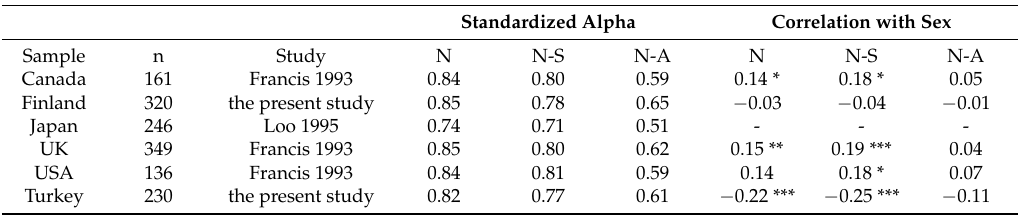
Table 1. Reliability coefficients and correlations with sex for the sex-related (N-S) and sex-free (N-A) components by Francis (1993) in some